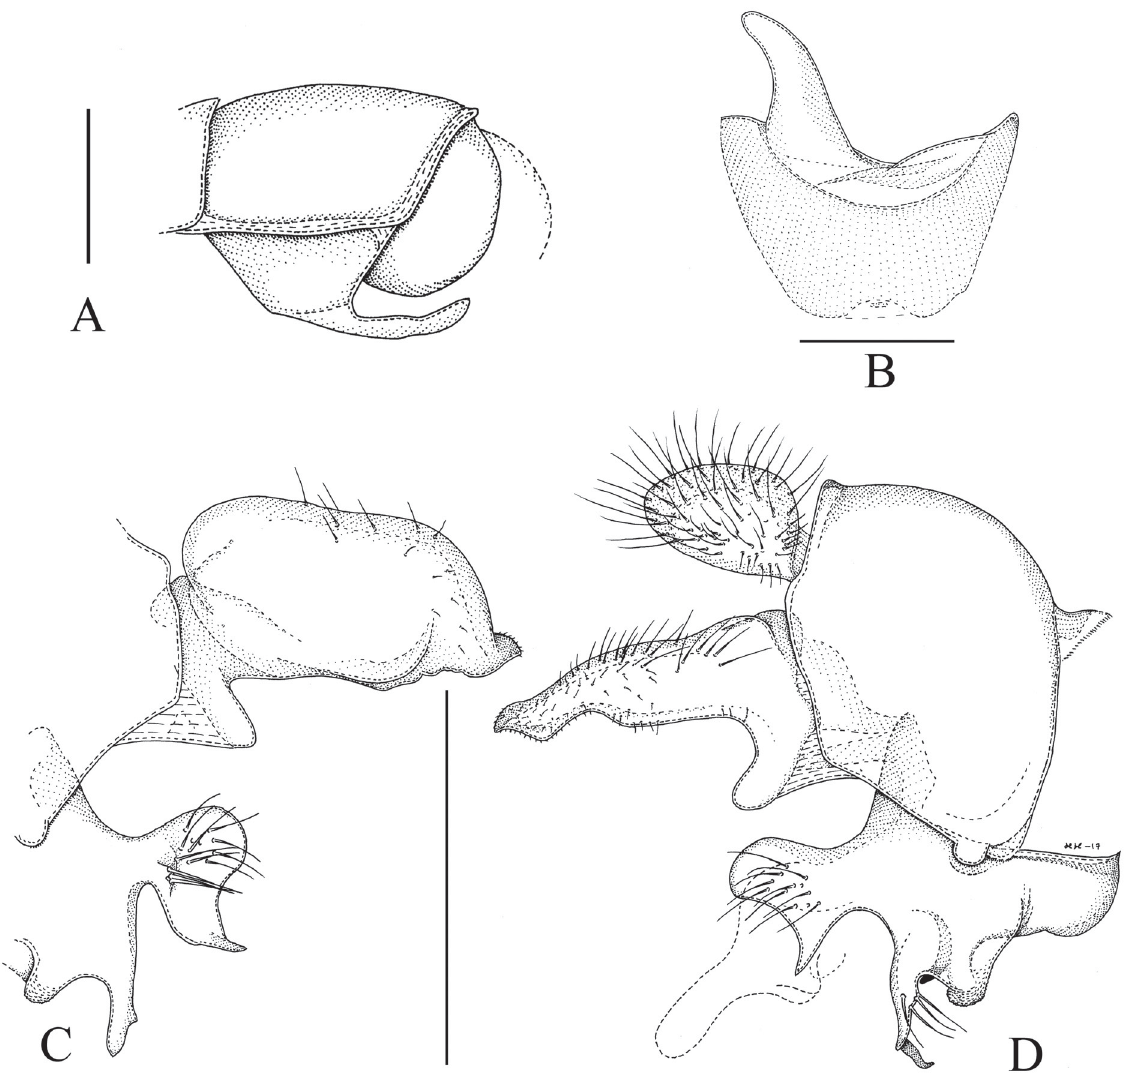
Fig. 48. Sphegina (Asiosphegina) in fl ata sp. nov., holotype, ♂ . A . Posterior part of abdomen, left side lateral view. B . Sternum IV, ventral view. C . Posterior part of genit alia, left side, lateral view. D . Genitalia right, side, lateral view. Scale bars = 0.5